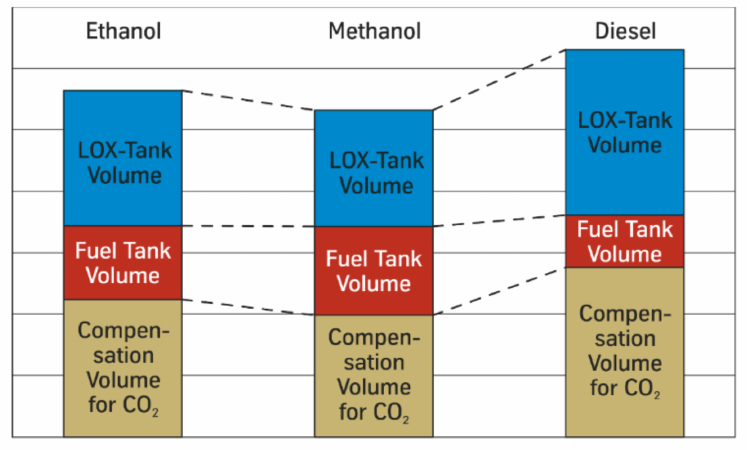
Figure 10. Relative Volume Comparison of Reformer Feedstocks